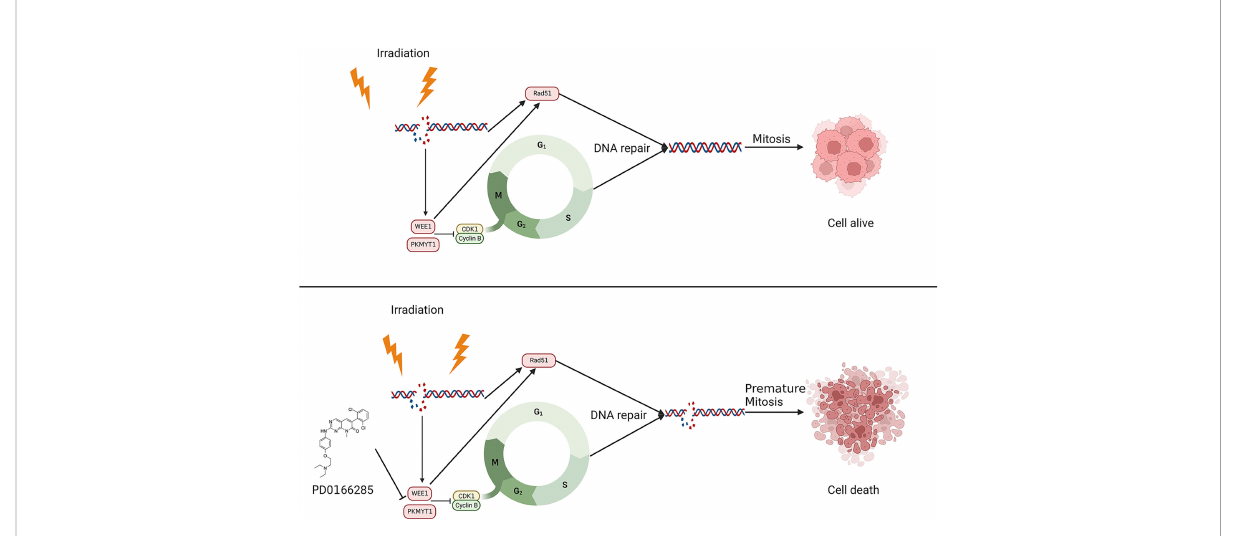
FIGURE 9 Schematic showing the potential therapeutic effects of PD toward